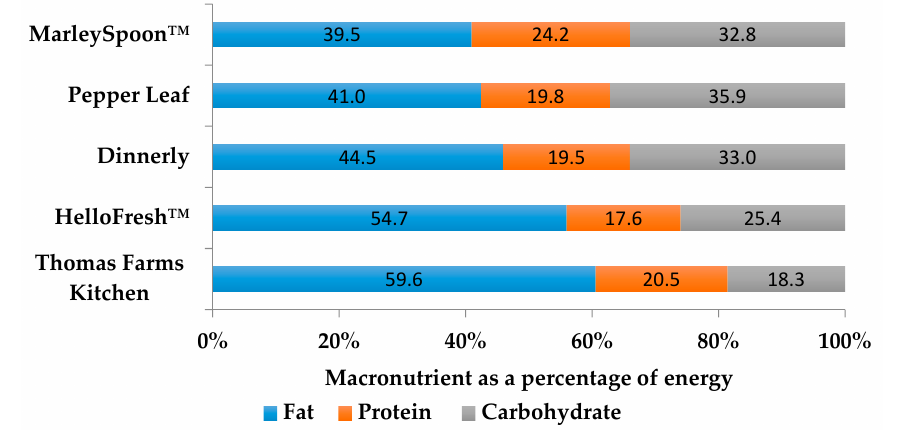
Figure 1. Average macronutrient profile expressed as a percentage of energy from 12 meals from each of the five meal kit subscription services.